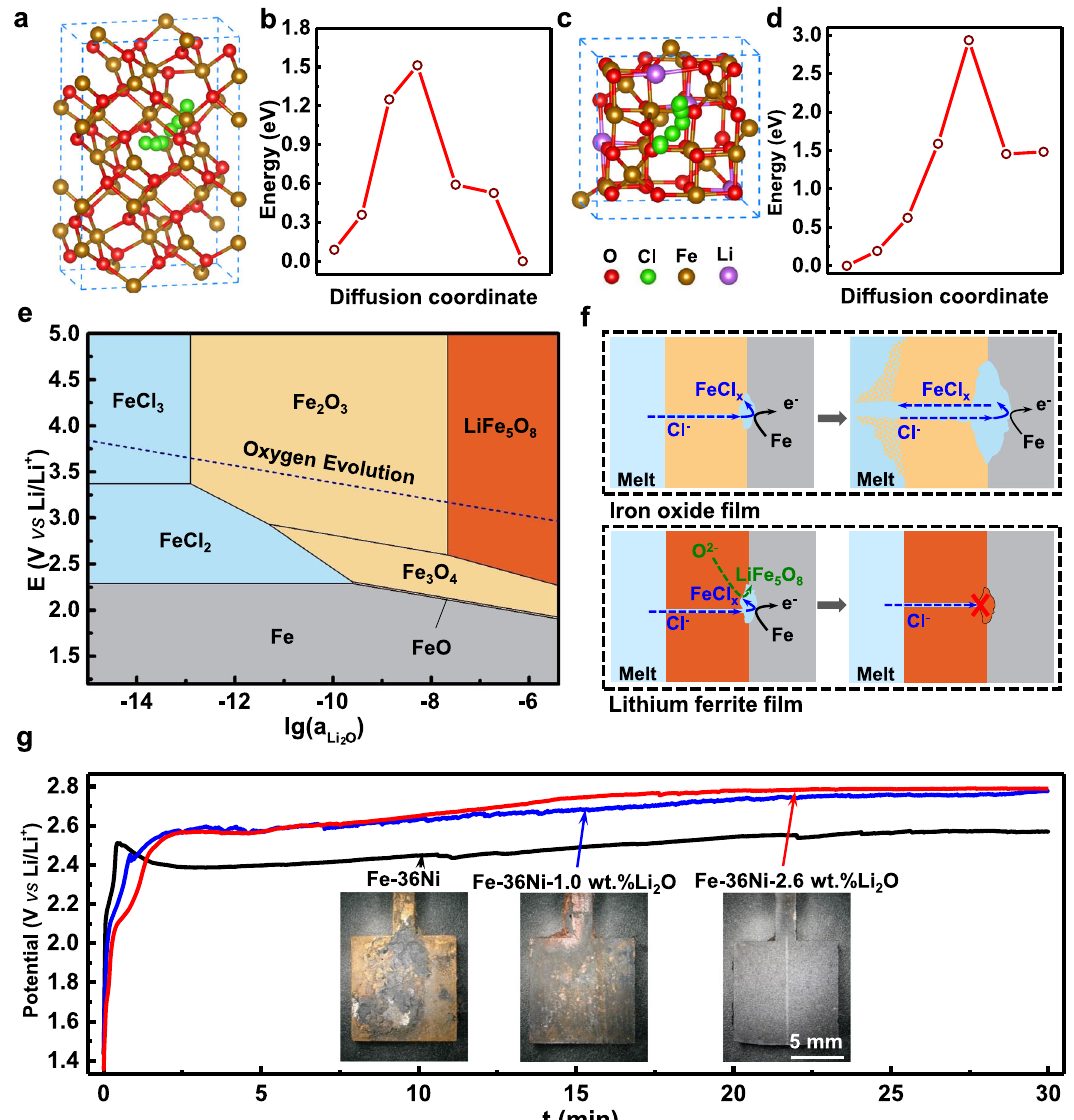
Fig.4|ProtectionmechanismoftheLFO fi lminmoltenchloride.a Clmigration paths in Fe 2 O 3 . b Cl migration energy pro fi le in Fe 2 O 3 . c Cl migration paths in LiFe 5 O 8 . d Cl migration energy pro fi le in LiFe 5 O 8 . e E-lg ð aLi (650°C, Supplementary Notes 3). f The proposed self-repair mechanism of the